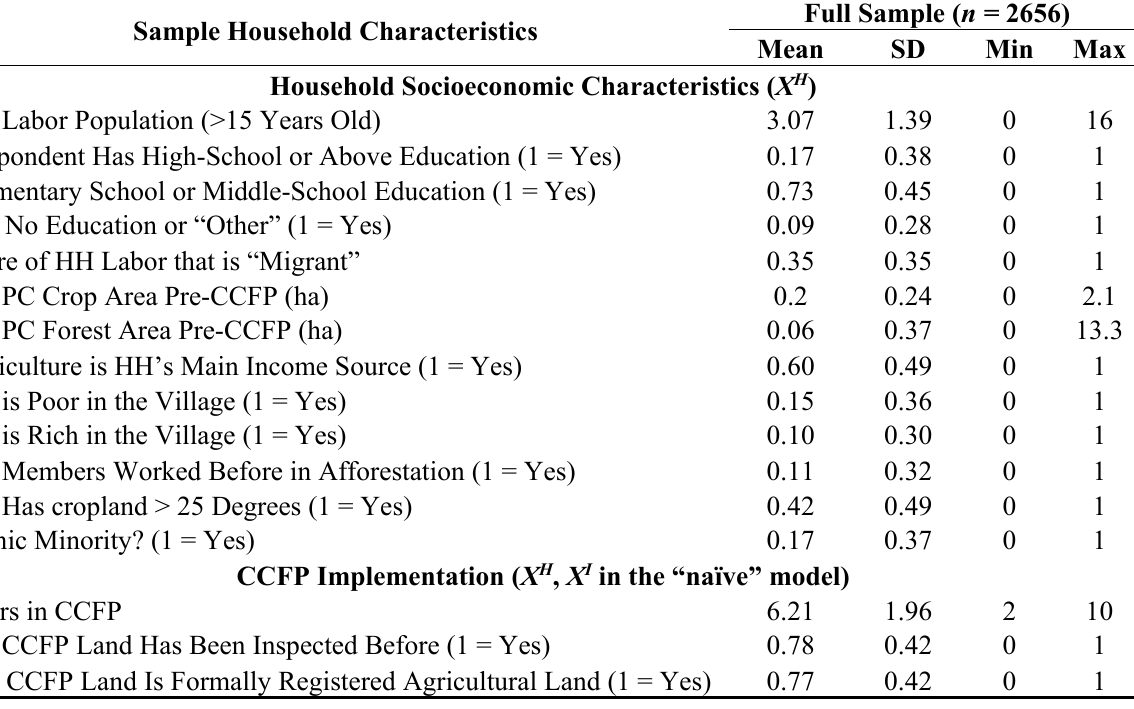
Table 2. Explanatory variables–household characteristics,